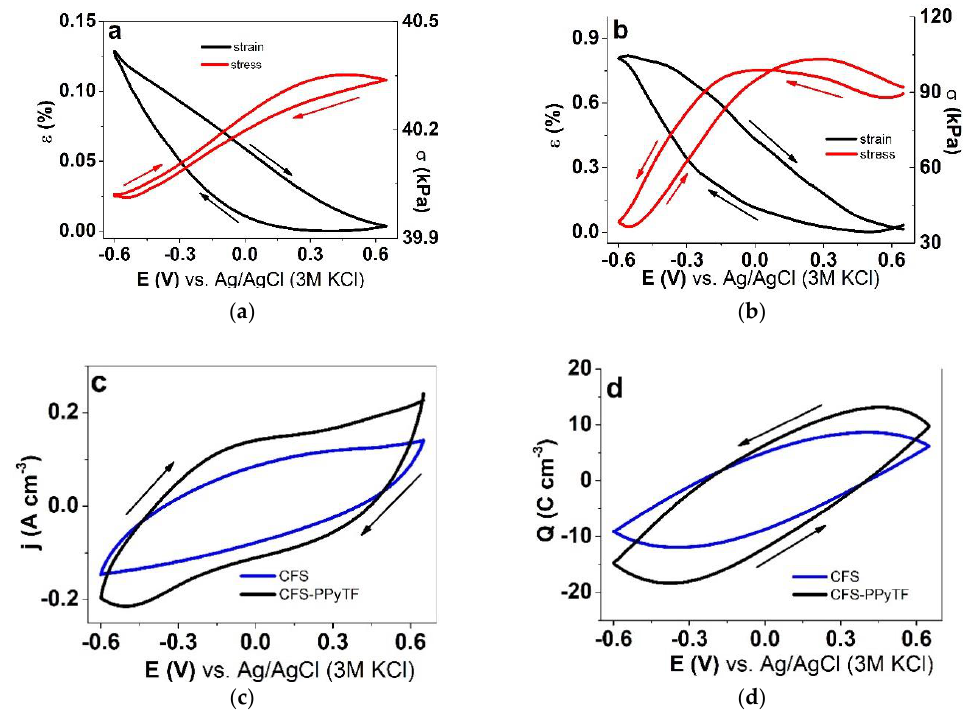
Figure 4. Cyclic voltammetry (scan rate 5 mV s − 1 ) of CFS and CFS-PPyTF samples in cell culture medium (CCM) electrolyte (potential range 0.65 V to − 0.6 V, 4th cycle) showing in strain ε (black) and stress σ (red) of ( a ) CFS samples strain ε and stress σ against potential E; ( b ) CFS-PPyTF samples strain ε and stress σ against potential E. The current density j and charge density curves Q against potential E of CFS samples (blue) and CFS-PPyTF samples (black) are shown in ( c ) and ( d ), respectively. The arrows indicate the start and end of the cycles.